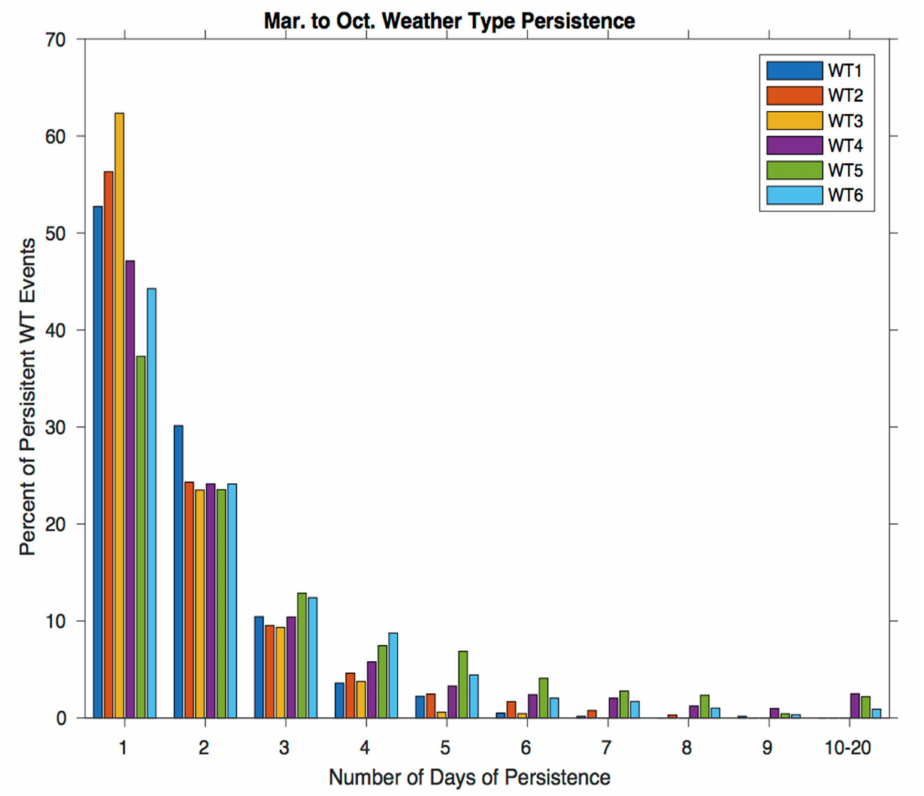
Figure 5. Persistence of the six WTs. presented by different color bars, respectively. The x-axis is the length of consecutive days with the same WT. The last group of bars are the sums of persistent events of 10 to 20 days. WT1-3 never have persistent events of over 10 days long. WT4, WT5, and WT6 have long persistence up to 20, 19, and 12 days,